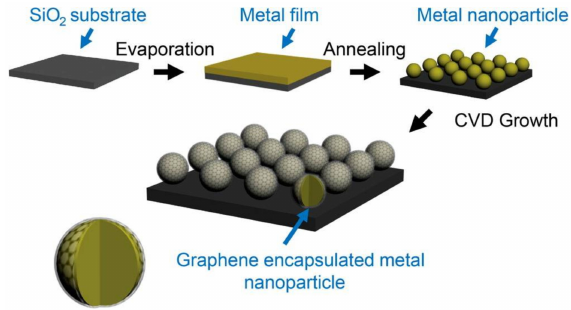
Figure 6. Production process for the Metal@Graphene to serve as a SERS-active substrate. Reproduced from [65] with permission; Copyright ACS